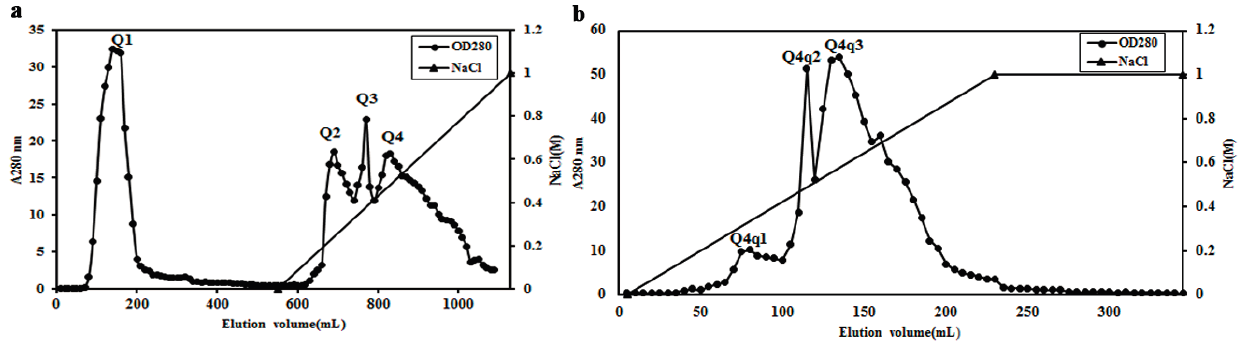
Figure 1. Profiles of purification obtained by ion-exchange chromatography on ( a ) the first Q-Sepharose column (3 cm × 25 cm) and ( b ) the second Q-Sepharose column (3 cm × 15 cm). The unadsorbed fraction Q1 was eluted with 10 mM Tris-HCl buffer (pH 7.5). The adsorbed fraction was eluted from the column using a linear (0–1 M) NaCl gradient in Tris-HCl buffer (pH 7.5) as indicated by the slanting line across the right half of the chromatogram. Q4 was the active fraction. (b) Fraction Q4 was loaded on a Q-Sepharose column (3 cm × 15 cm). The line with triangular symbols indicates elution of adsorbed proteins with a 0–1 M NaCl gradient in 10 mM Tris-HCl buffer (pH 7.2). ACE inhibitory activity was detected only in fraction Q4q2.